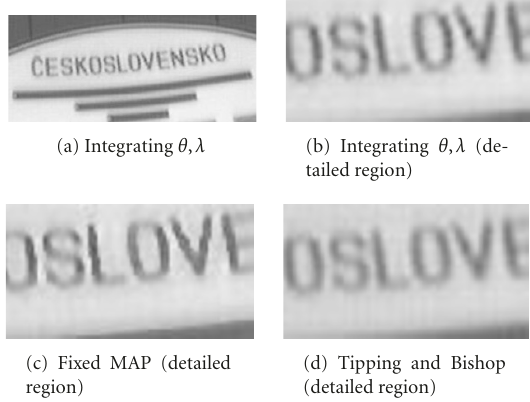
Figure 11: (a) The full super-resolution output from our algorithm. (b) Detailed region of the central letters, again with our algorithm. (c) Detailed region of the regular Huber MAP super-resolution im- age, using parameter values suggested in [18], which are also found to be subjectively good choices. The edges are slightly artificially crisp, but the large smooth regions are well regularized. (d) Close- up of letter detail for comparison with Tipping and Bishop’s method of marginalization. The Gaussian form of their prior leads to a more blurred output, or one that over fits to the image noise present on the input